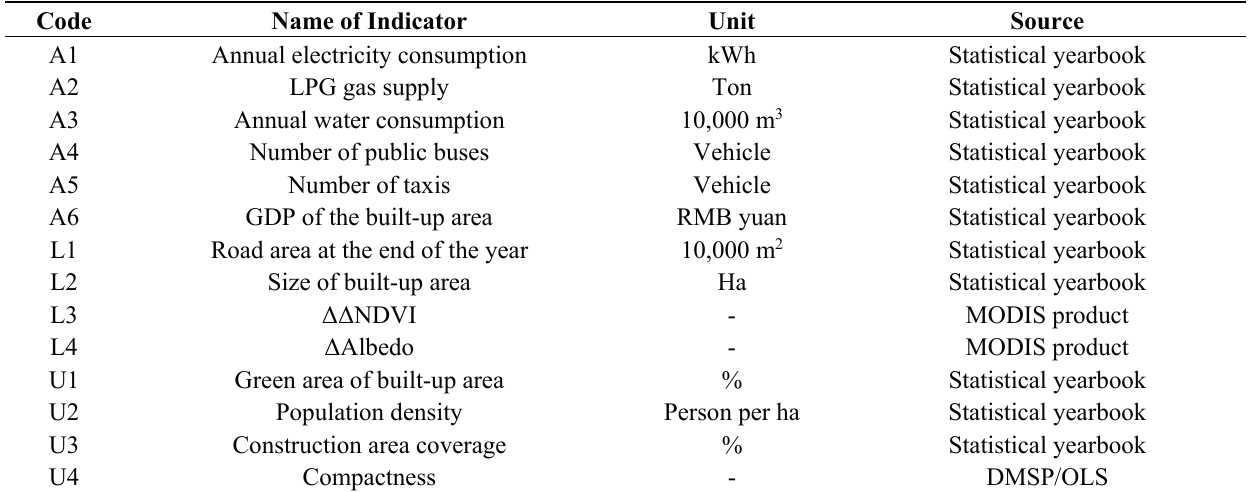
Table 1. Selected variables related to